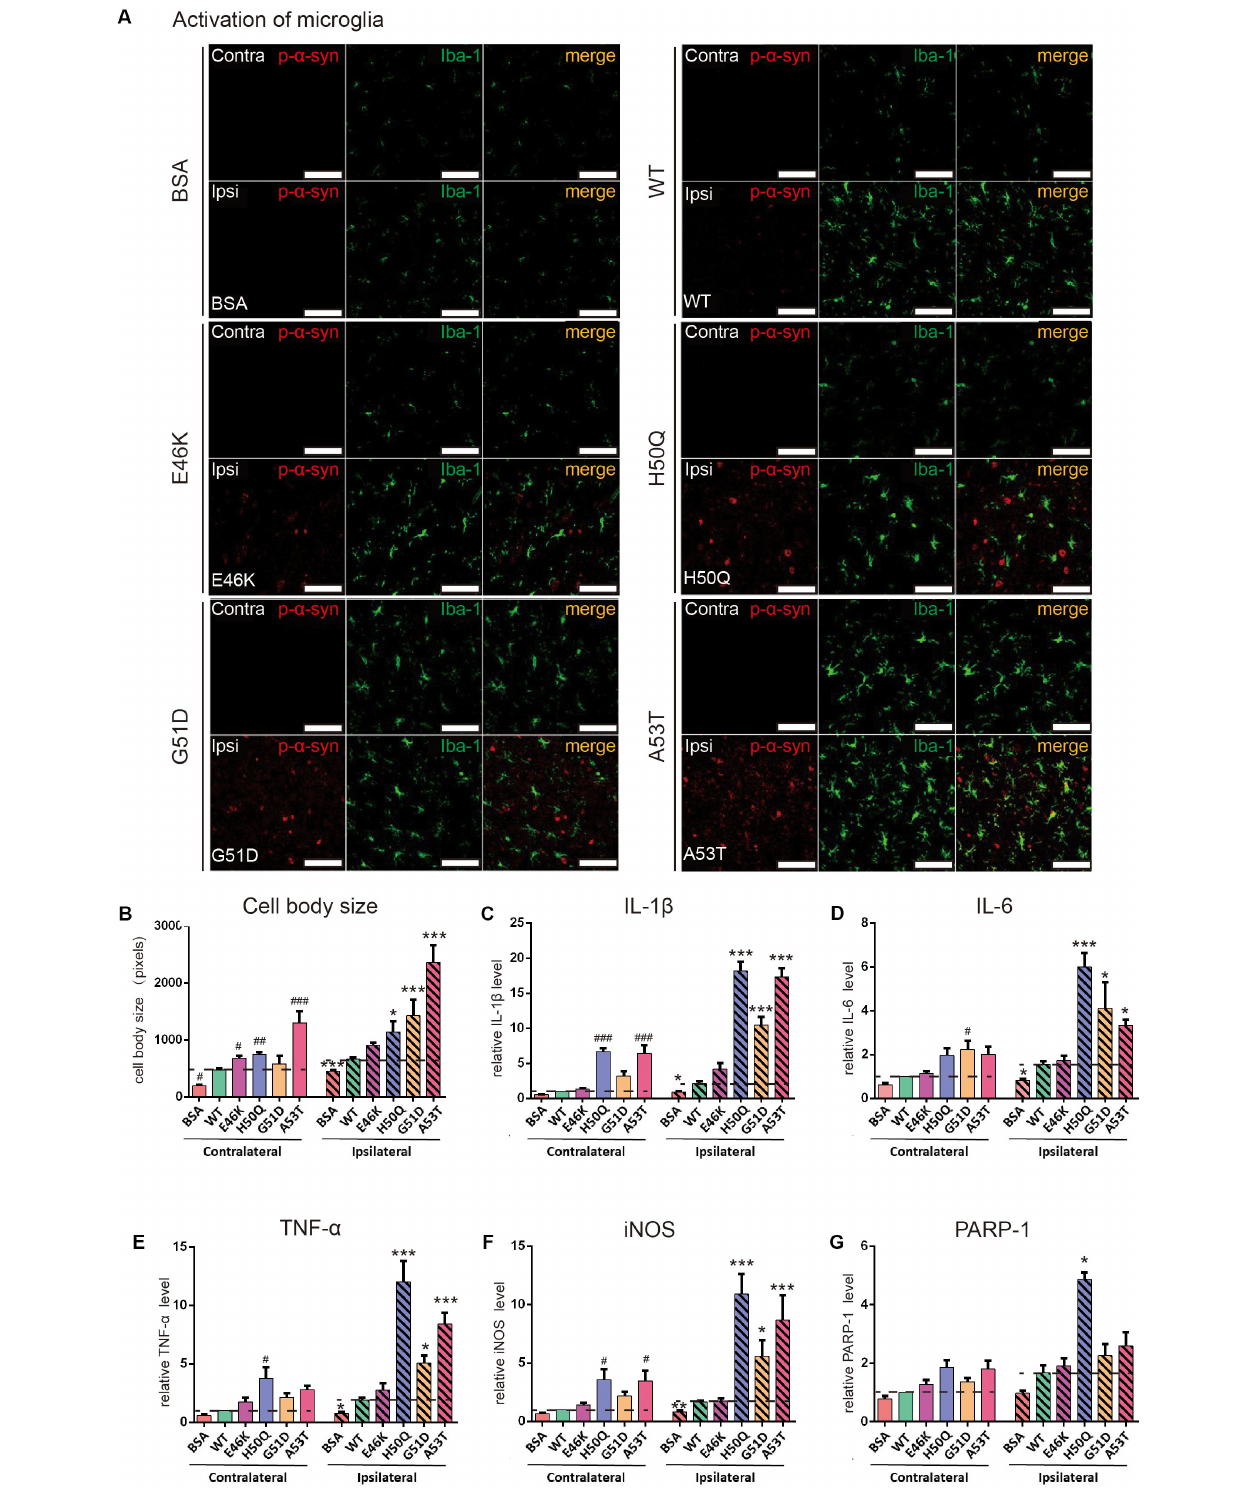
FIGURE 7 | WT and pathogenic mutant PFFs activate microglial cells. (A) Confocal images of microglia (Iba1, green) co-stained with p- α -syn (red) 24 h after injection (scale bars, 100 µ m. (B) Cell body size of microglia. (C–G) mRNA levels of IL-1 β (C) , IL-6 (D) , TNF- α (E) , iNOS (F) , and PARP-1 (G) assessed by qRT-PCR. Mean ± SEM; contralateral: # P < 0.05, ## P < 0.01, ### P < 0.001 compared to WT; ipsilateral: * P < 0.05, ** P < 0.01, *** P < 0.001, one-way ANOVA followed by Dunnett’s test compared to WT; n = 6 animals.